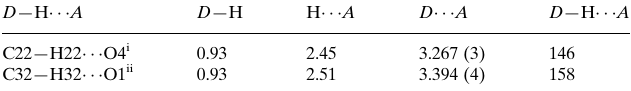
Hydrogen-bond geometry (A˚ , (cid:3)